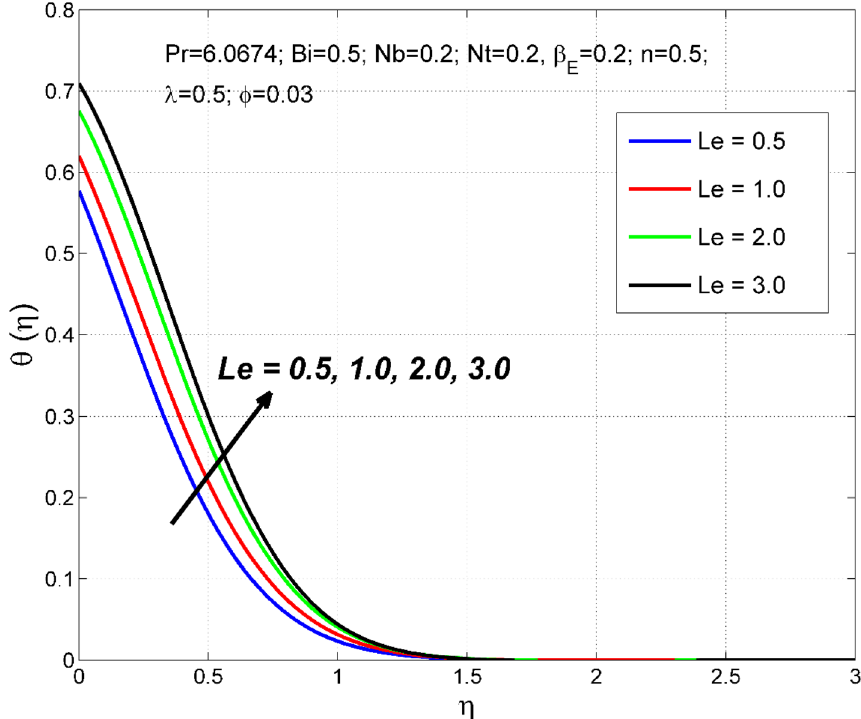
Figure 11. The temperature distribution θ (η) behavior for the variation of the Lewis number Le .